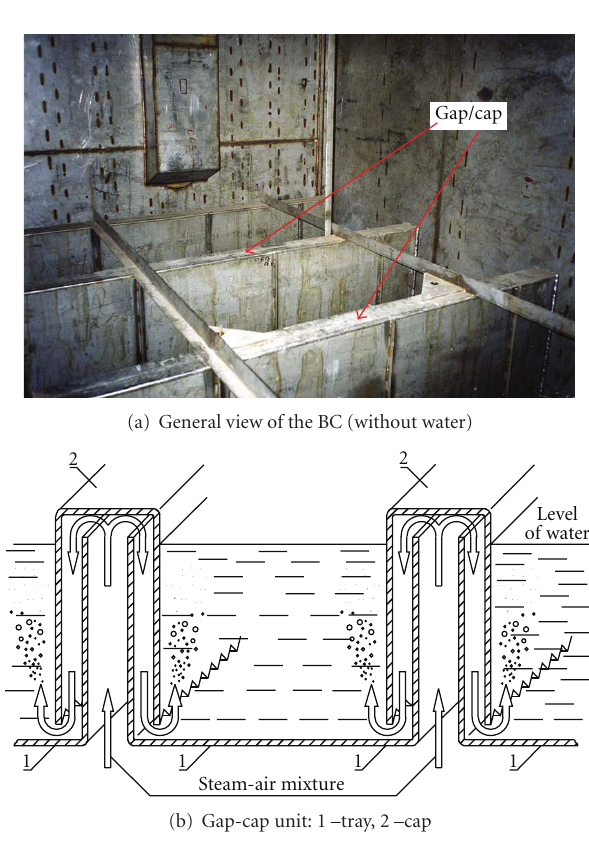
Figure 3: Gap/cap systems of the BC V-213 test facility.